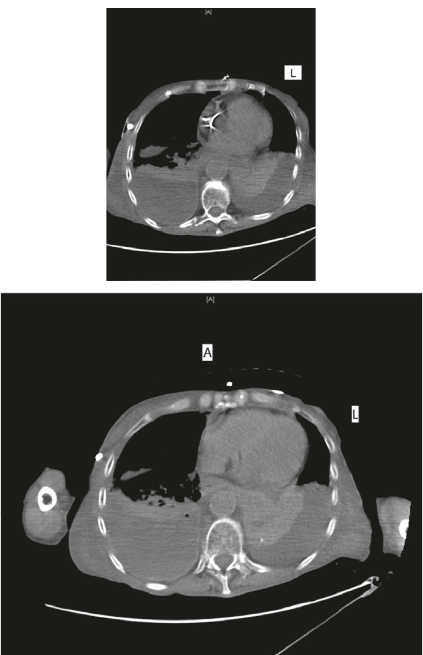
Figure 2: CTof the chest without contrast showing bilateral pleural fluid collections, which were larger and more complex appearing on the